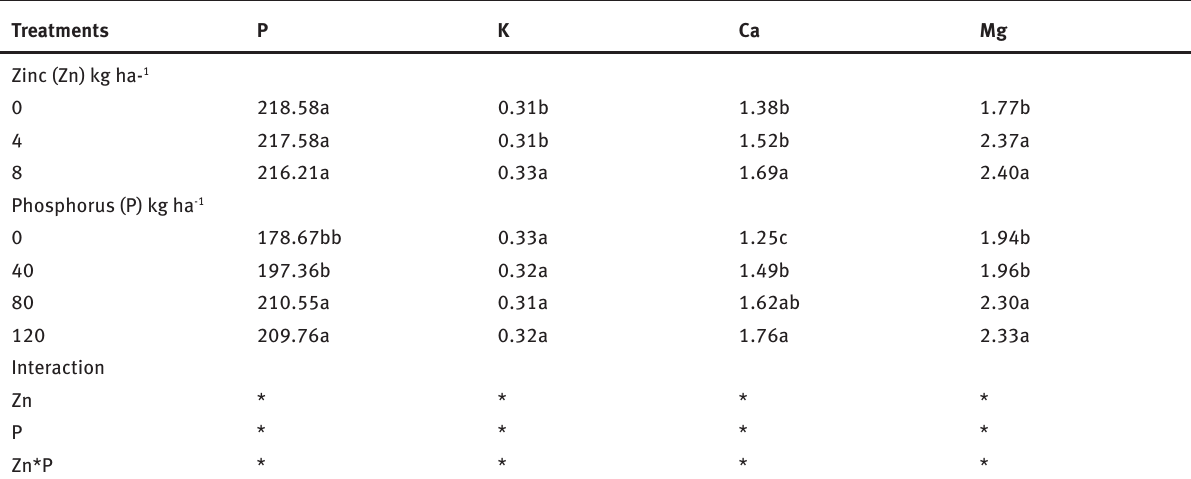
Table 4: Effect of Zn and P fertilizers on the concentration of nutrient elements (mg kg -1 ) in groundnut seed based on the mean from 2017 and 2018 cropping